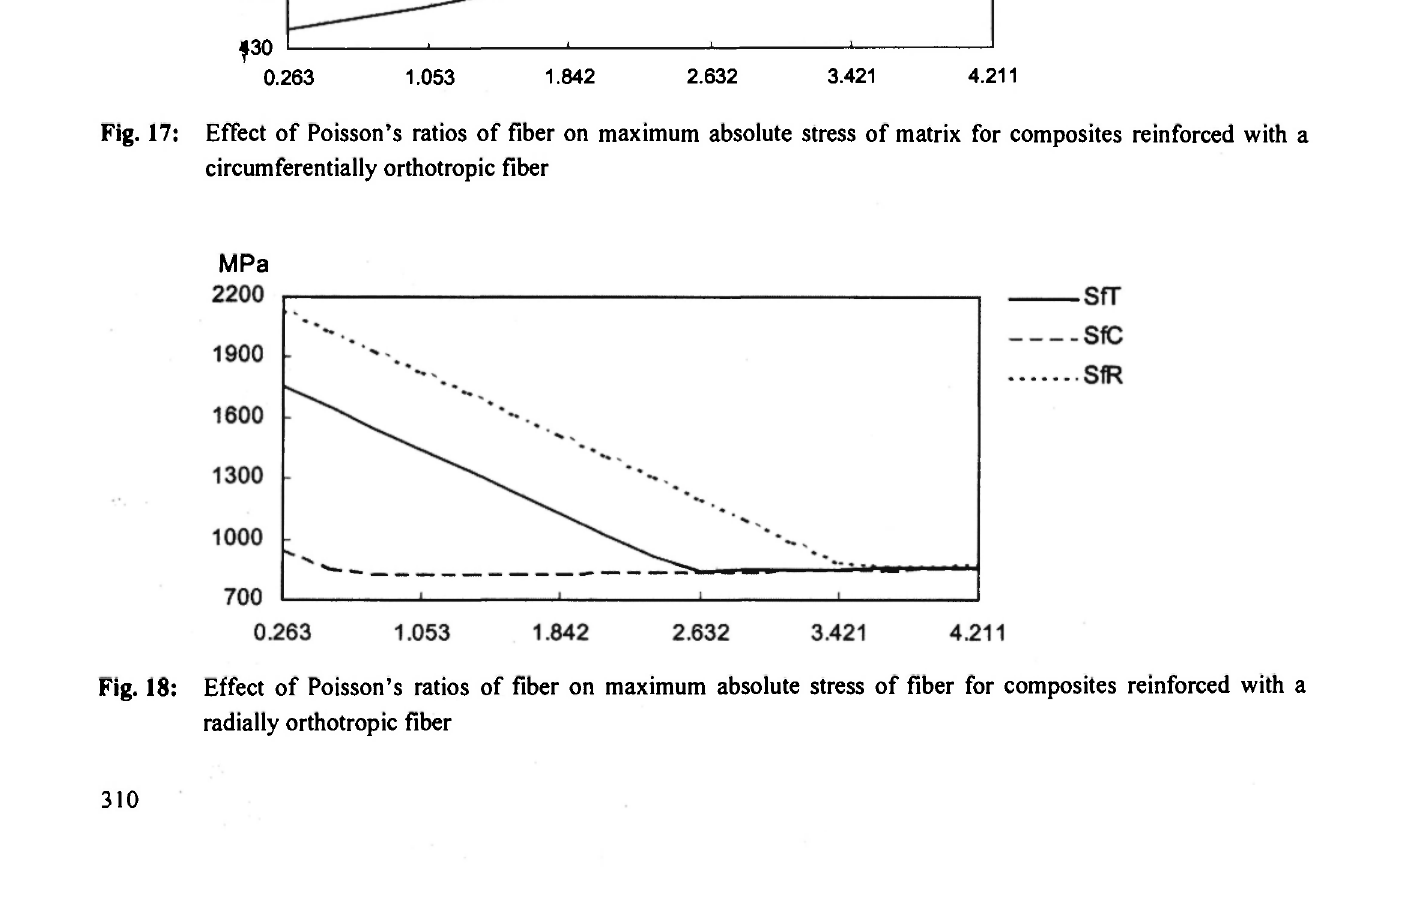
Fig. 16: Effect of Poisson's ratios of fiber on maximum absolute stress of fiber for composites reinforced with a transversely isotropic fiber